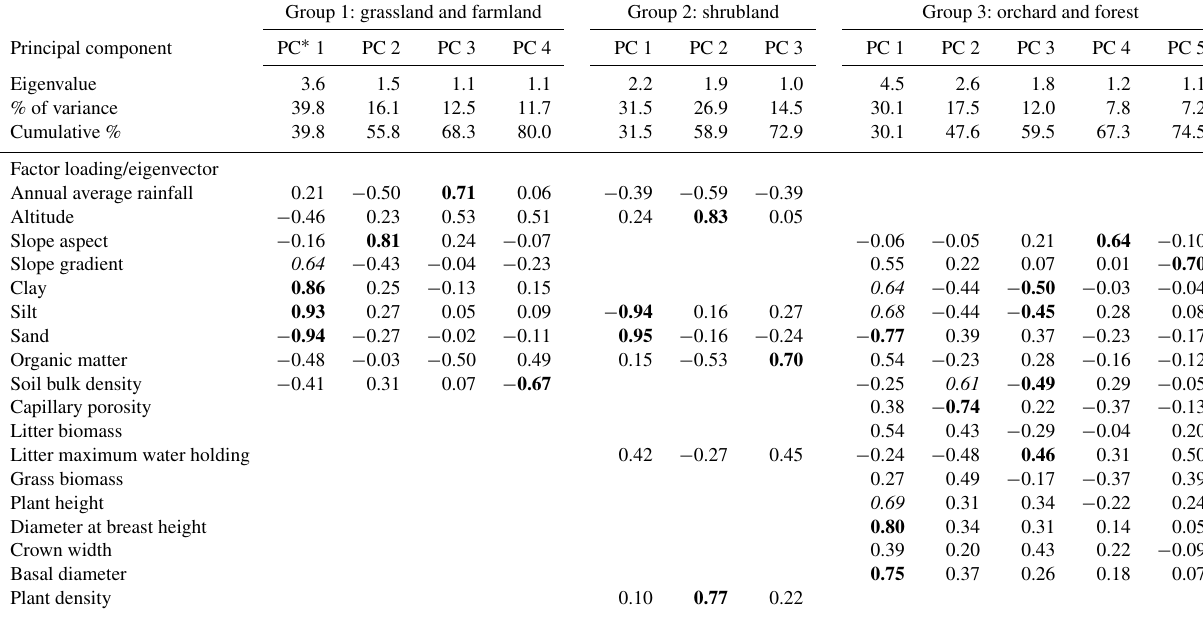
Table 5. Principle component analysis (PCA) of environmental attributes. Group 1: grassland and farmland Group 2: shrubland Group 3: orchard and forest